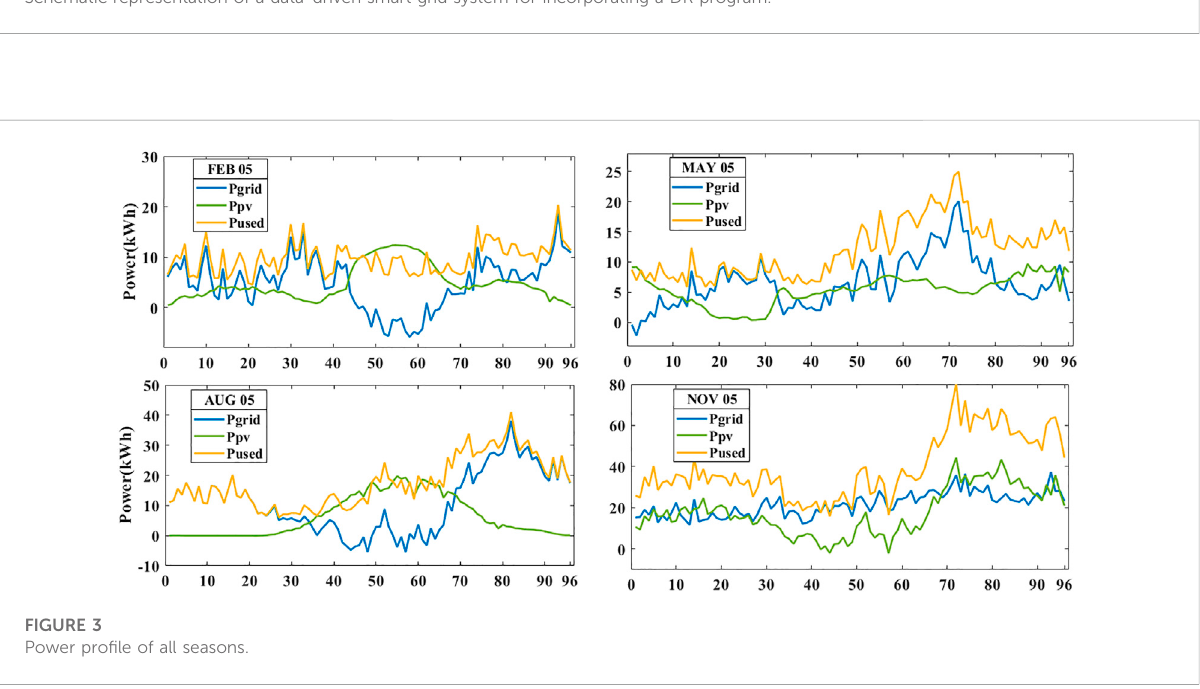
FIGURE 3 Power pro fi le of all